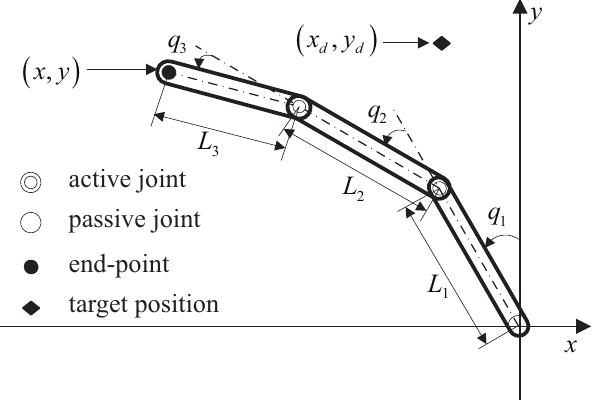
Figure 2. schematic diagram of